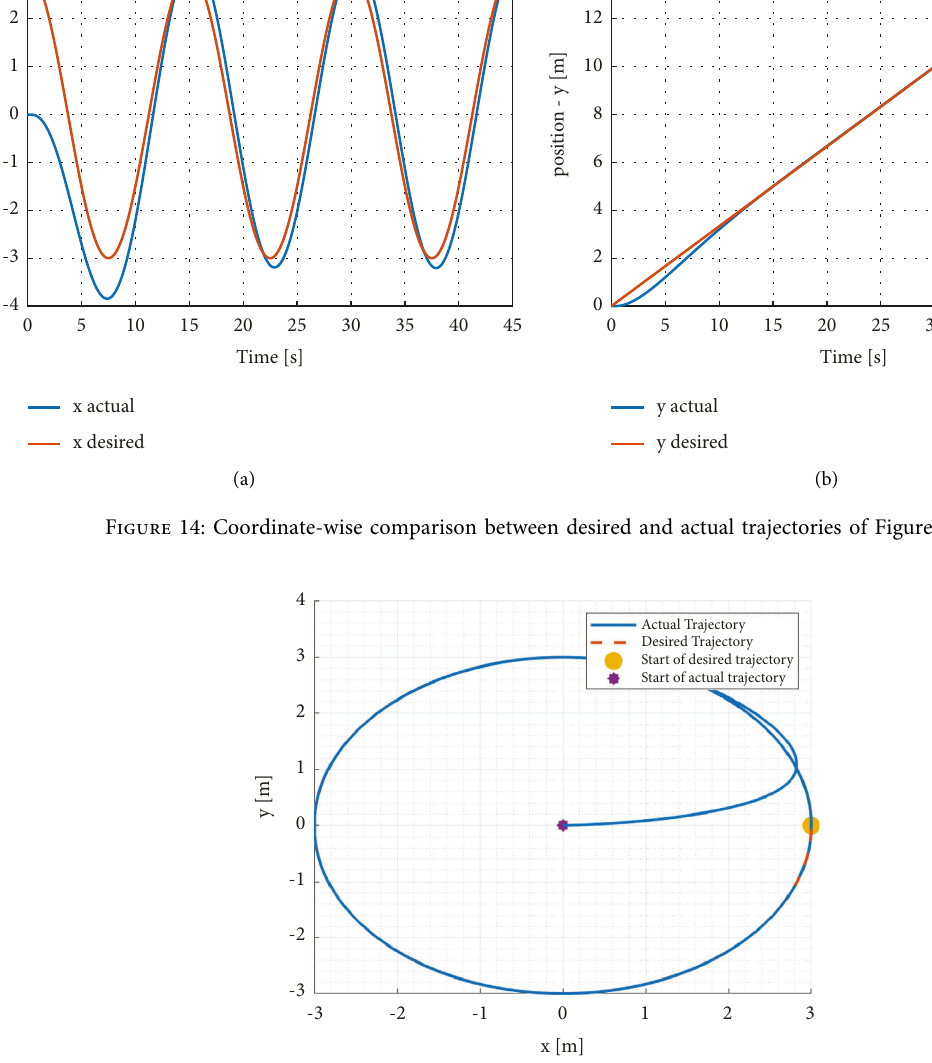
Figure 15: Desired and actual trajectories with feedback linearization and PD